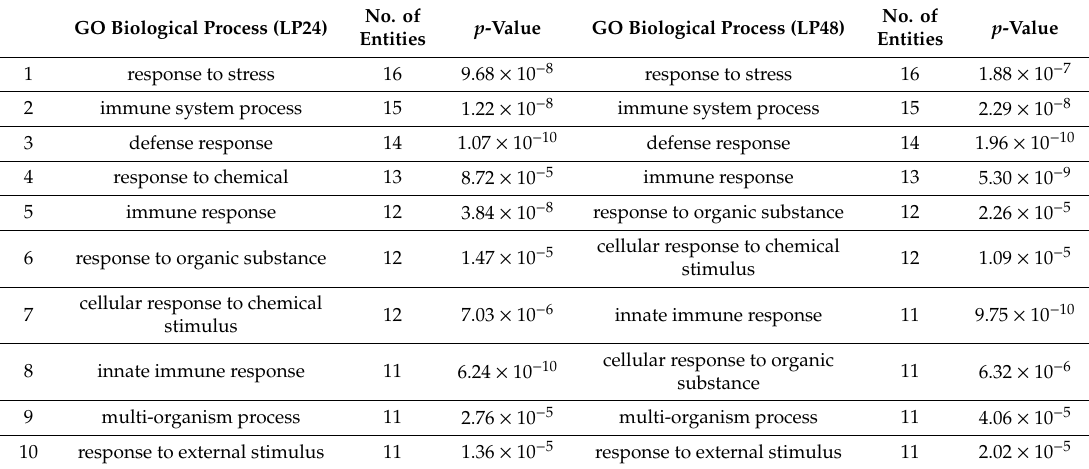
Table 4. Upregulated proteins (log 2 FC ≥ 2) other than APPs were assigned to biological process categories in LP based on the Gene Ontology analysis of proteins, and the top 10 categories are